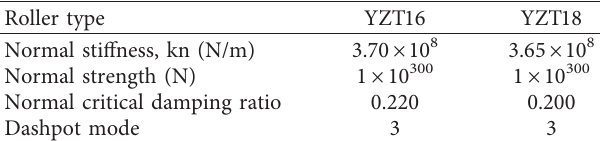
Table 8: Microparameters of